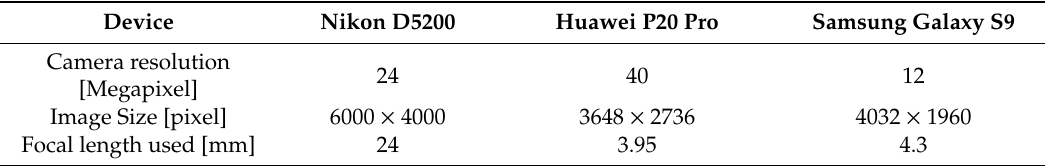
Table 1. Specifications of devices used for SfM surveys.